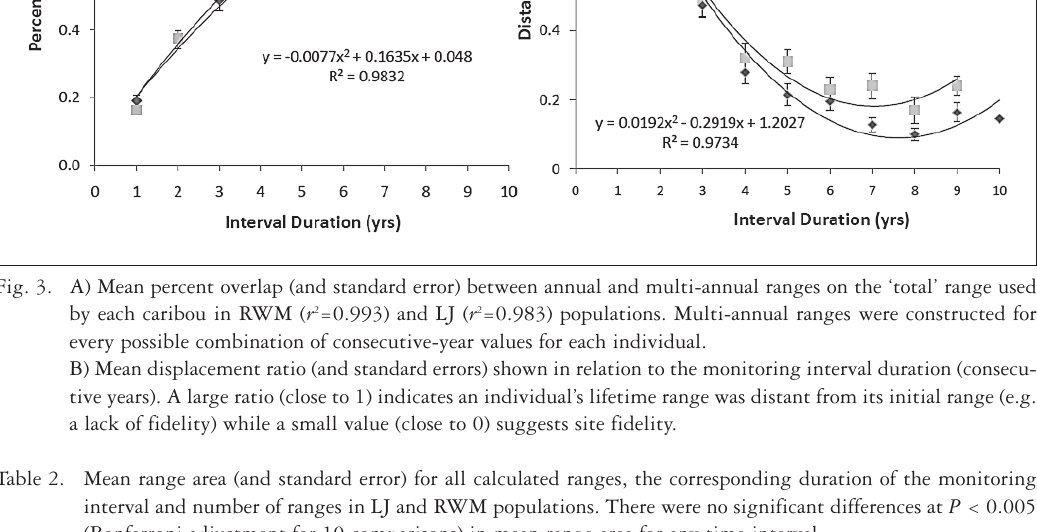
Table 2. Mean range area (and standard error) for all calculated ranges, the corresponding duration of the monitoring interval and number of ranges in LJ and RWM populations. There were no significant differences at P < 0.005 (Bonferroni adjustment for 10 comparisons) in mean range area for any time interval. LJ RWM Years Mean km 2 (SE) N (# Ranges) Years Mean km 2 (SE) N (#